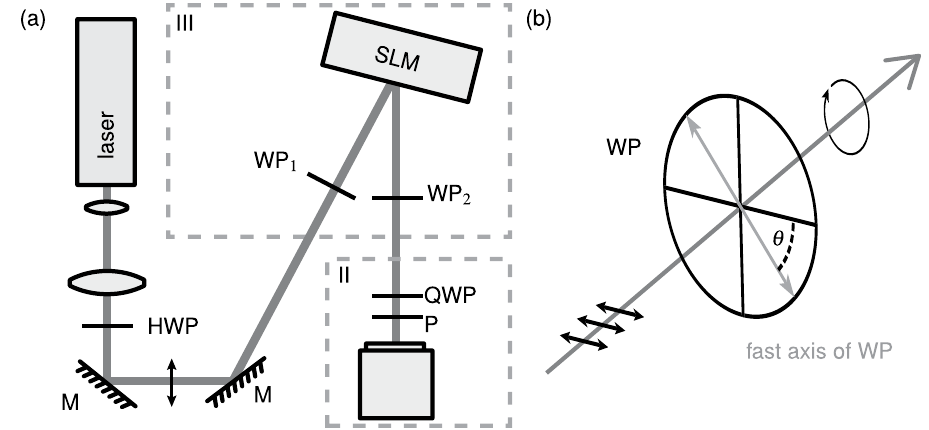
Figure 4. Schematic of ( a ) an experimental setup including (III) the DPMS and (II) a polarization measurement system; ( b ) the orientation angle θ of a wave plate (WP) defined as the inclination of its fast axis to the linear horizontal input polarization, here shown for θ = − 45°. C: camera, (H/Q)WP: (half/quarter) wave plate, M: mirror, P: